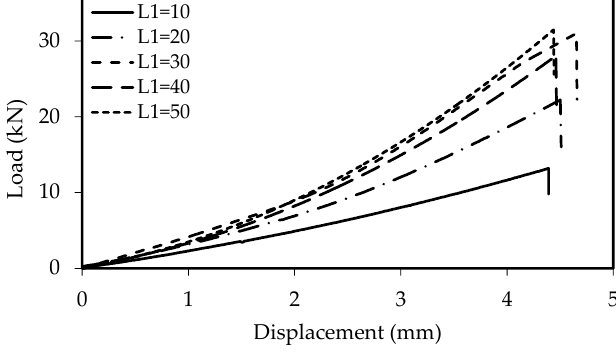
Figure 2. Double strap joints (DSJs) prepared for experiments ( a ) before the test; ( b ) after the test.